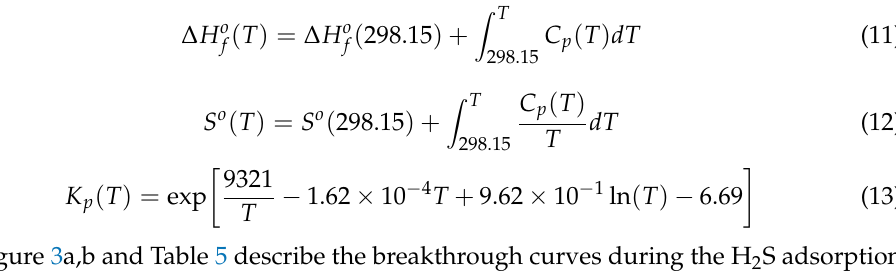
Figure 4. Linearized deactivation kinetic model ln(ln(C 0 /C)) vs. time and breakthrough curves fitting ( a , b ) calculated by using GHSV equal to 50,000 (upper) at 450, 500, 550, and 600 °C and linearized deactivation kinetic model ln(ln(C 0 /C)) vs. time and breakthrough curves fitting ( c , d ) calculated by using GHSV equal to 25,000 h − 1 (lower) at 450, 550, and 600 °C.